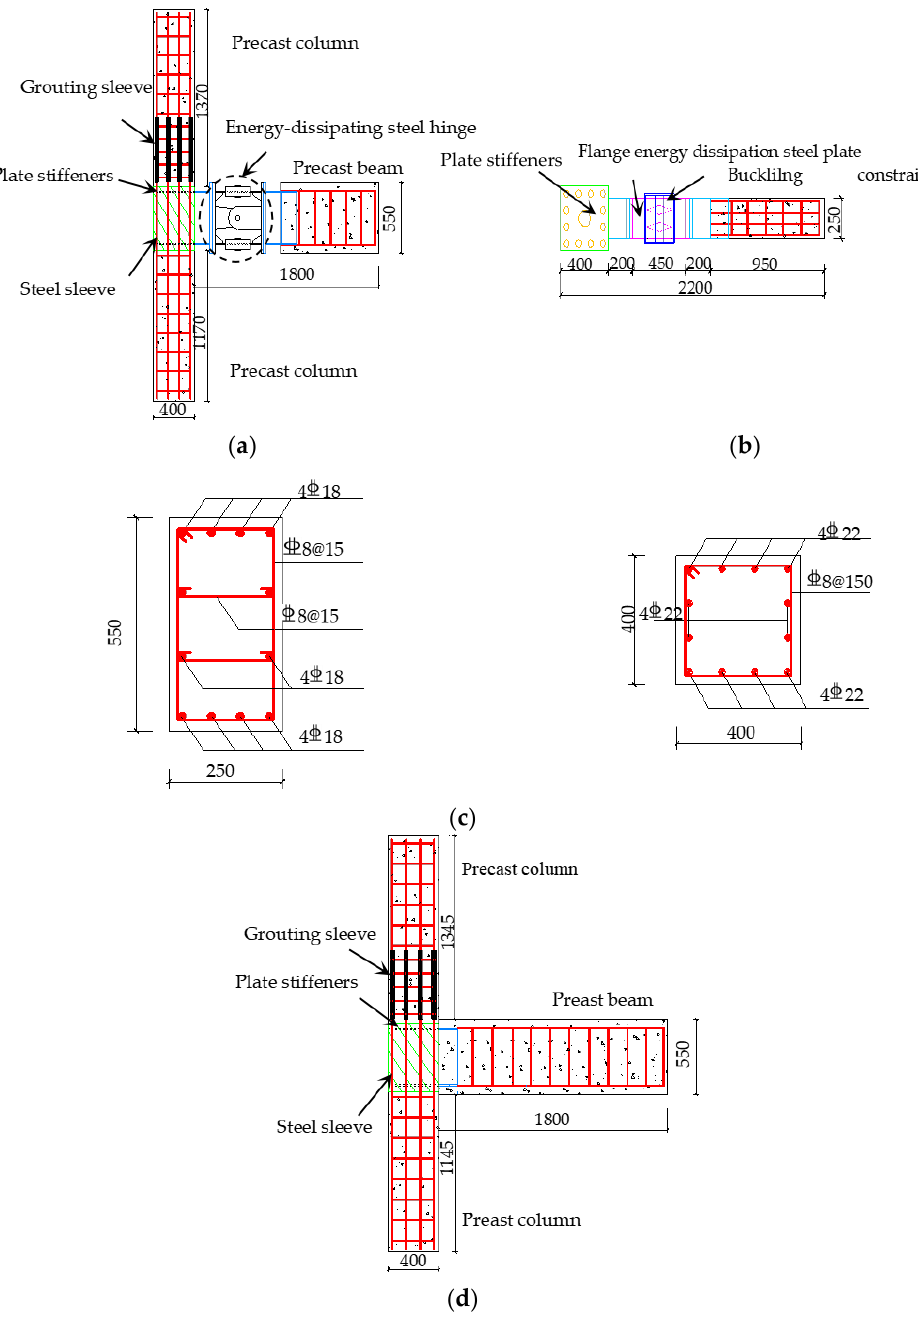
Figure 2. ( a ) Front view of the precast replaceable beam-to-column joint with an energy-dissipating steel hinge; ( b ) vertical view of the precast replaceable beam-to-column joint with an energy- dissipating steel hinge; ( c ) configurations of the beam and column; ( d ) front view of the steel sleeve confined concrete joints (unit: